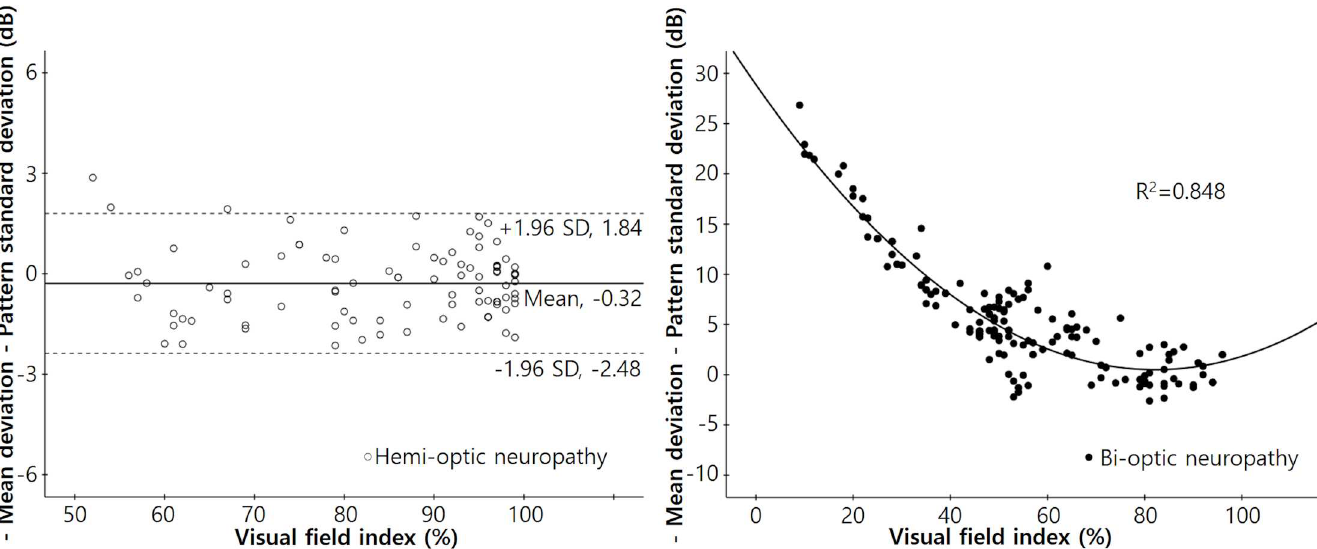
Fig 4. Scatterplots of the differences between the negative MD and PSD values with respectto the visual field index in each group. Left: A scatterplot of the difference betweenthe negative MD and PSD values ( − MD − PSD)with respect to the visual field index (VFI) of patients with hemi-optic neuropathy (either superioror inferior) (r 2 = 0.0001, P = 0.916). The mean “ − MD − PSD” was − 0.32 dB, and the 95% confidenceinterval rangedfrom − 2.48 dB to 1.84 dB. Right: A scatterplot of the “ − MD − PSD” with reference to the VFI in patients with bi-opticneuropathy(thus both superiorand inferior). The ‘ − MD − PSD” increasedsignificantly as the VFI decreased. Correlationswere calculatedusing the followingequation: Y = 28.868 − 0.690X + 0.004X 2 (r 2 = 0.848, P < 0.001).